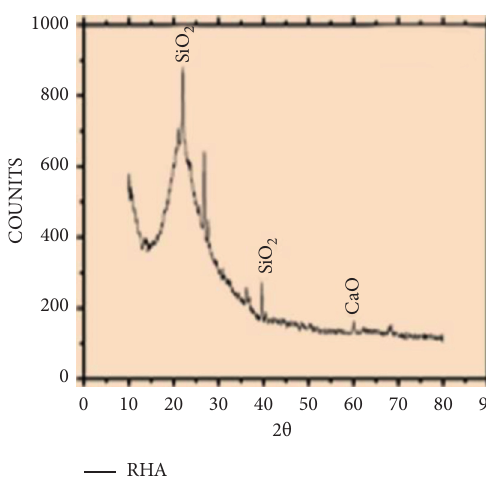
Figure 5: XRD patterns of